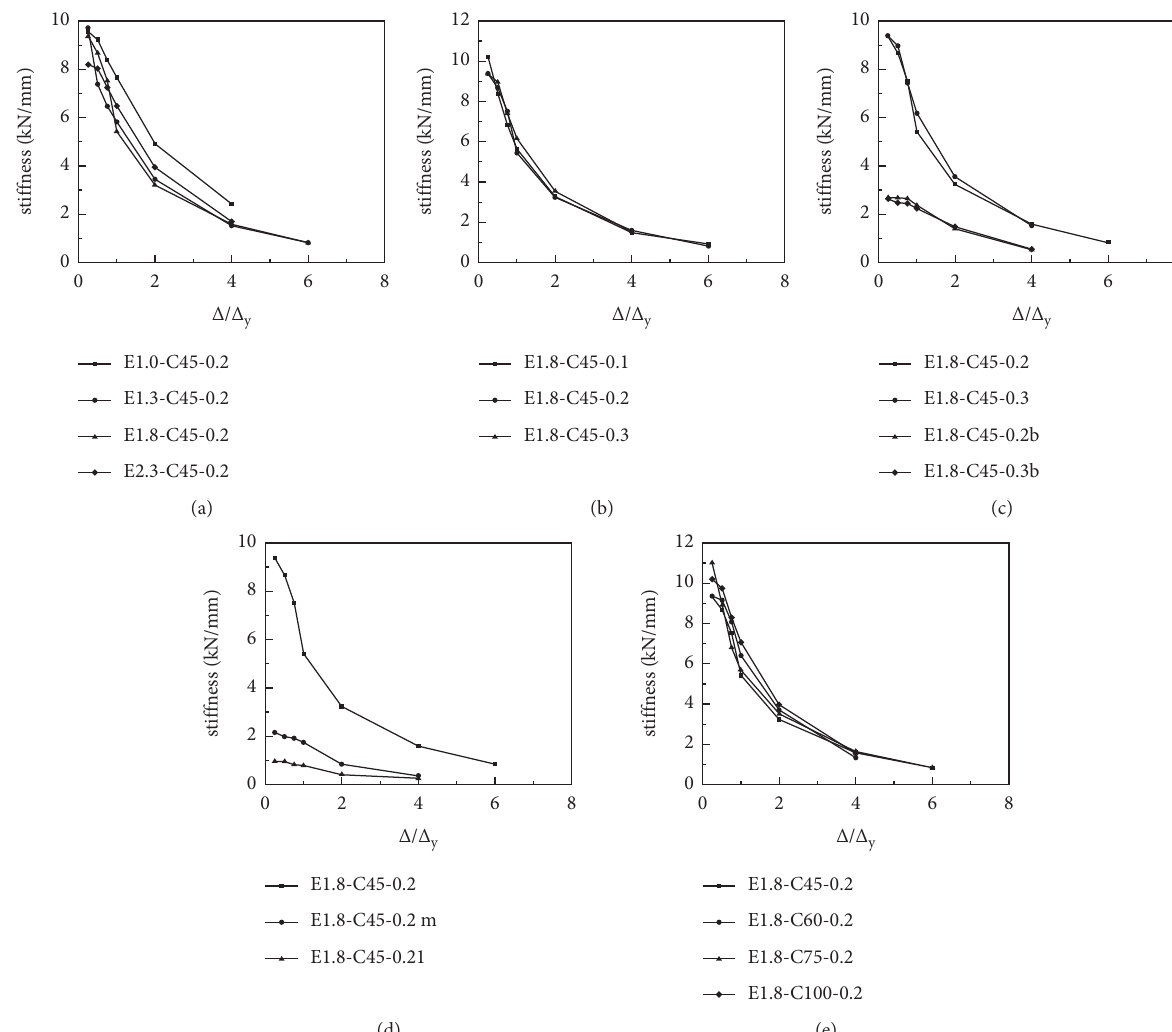
Figure 11: Stiffness of test specimens. (a) Variation of aspect ratio. (b) Variation of axial compression ratio. (c) Variation of bending axis. (d) Variation of slenderness ratio. (e) Variation of concrete